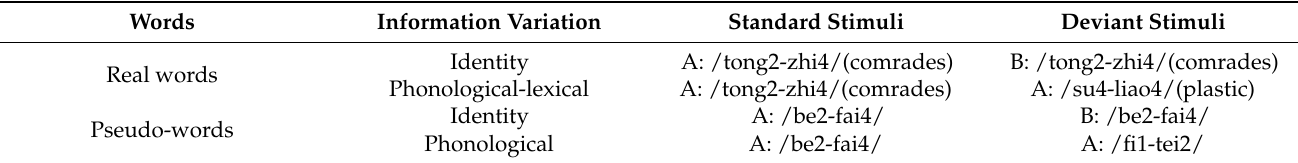
Table 1. The standard and deviant stimuli in each experimental condition (A and B refer to two different